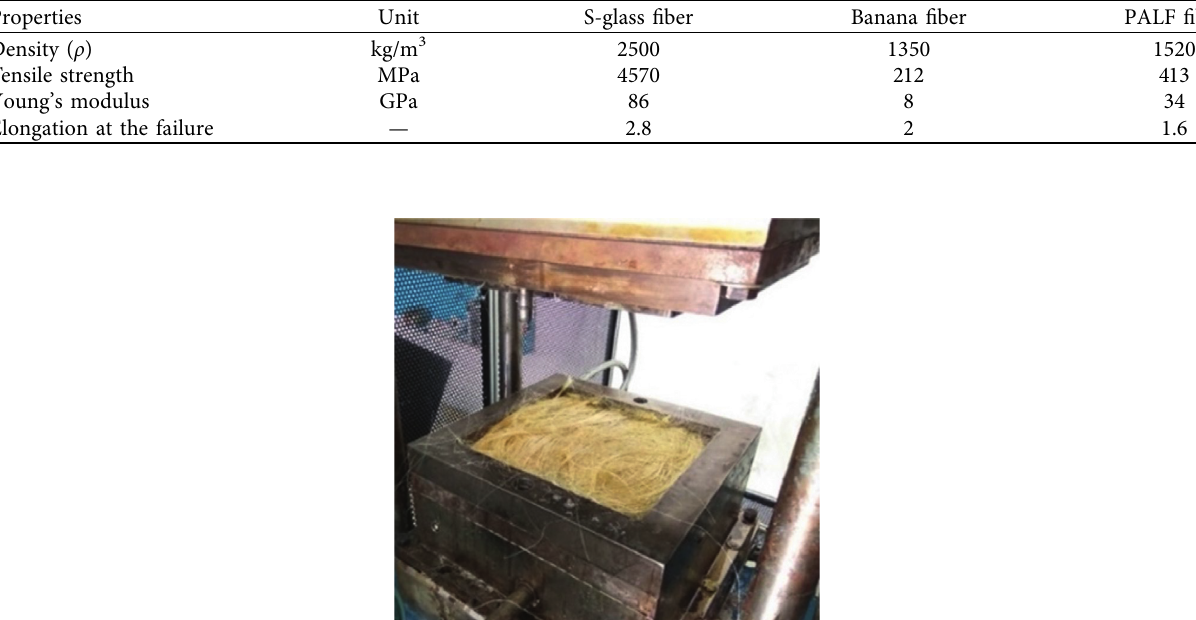
Table 1: Properties of tested